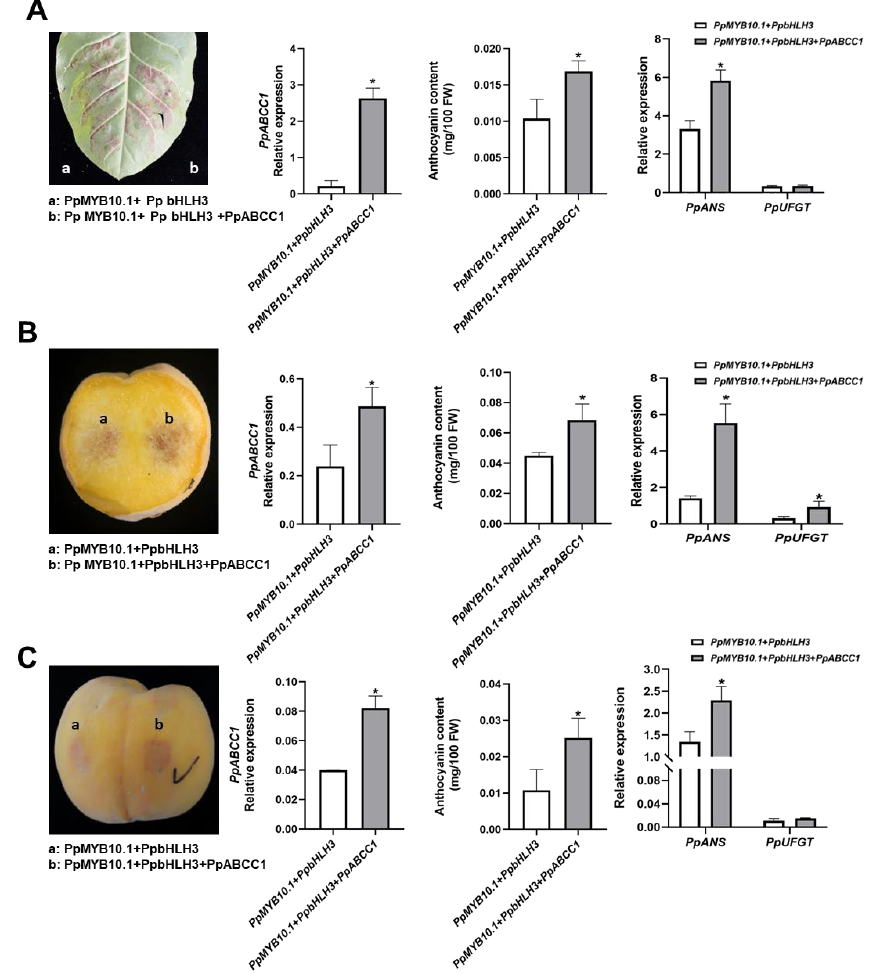
Figure 7. Transient overexpression of PpMYB10.1 + PpbHLH3 with or without PpABCC1 in tobacco leaves ( A ) and peach (cv. ‘Huangjinmi’) fruit ( B , C ). Relative expression of PpABCC1 and anthocyanin biosynthetic genes, changes in anthocyanin contents in tobacco leaves ( A ) and peach fruit ( B , C ). Data were means ( ± SD) from three biological replicates. *, Significant difference at p < 0.05